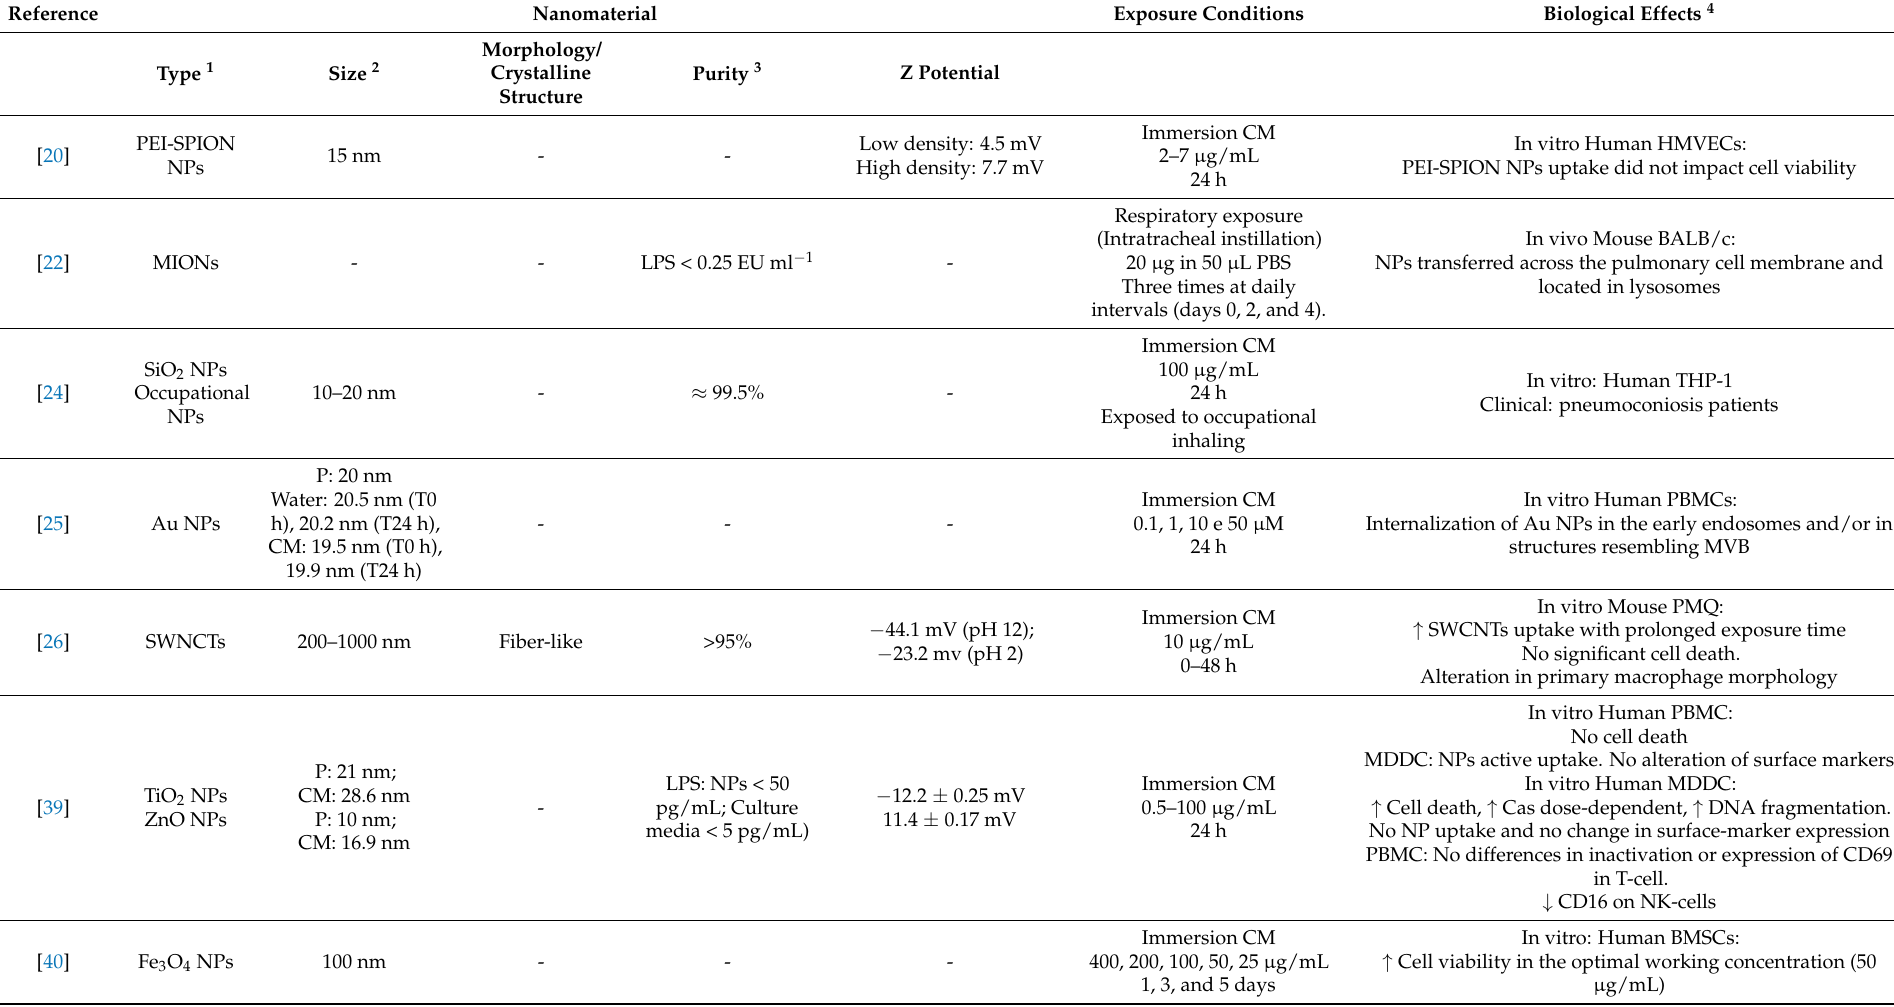
Table 2. Physicochemical characteristics of NMs, exposure conditions, and biological effects observed in the respective experimental